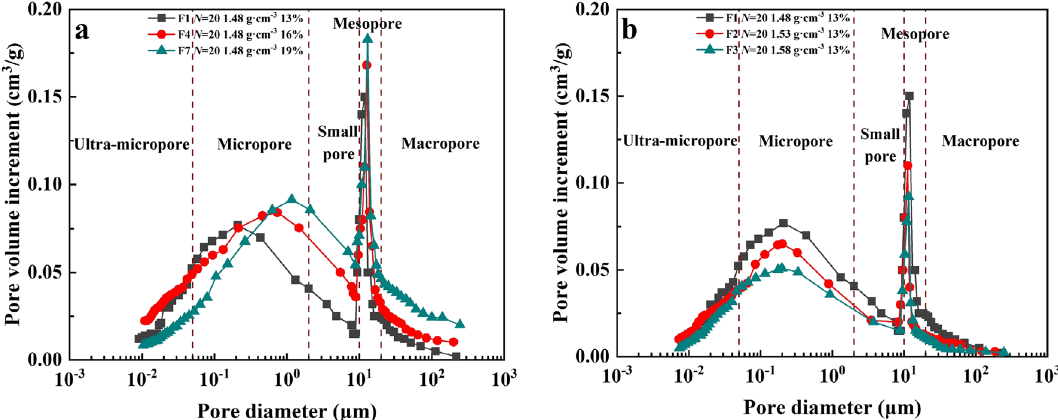
Figure 11. Pore-size distribution cures with different water content and dry density or soils at the study site in the floodplain of southwestern Shandong Province: ( a ) The dry density is 1.48 g cm −3 , pore-size distribution cures with different water contents. ( b ) The water content is 19%, pore-size distribution cures with different dry